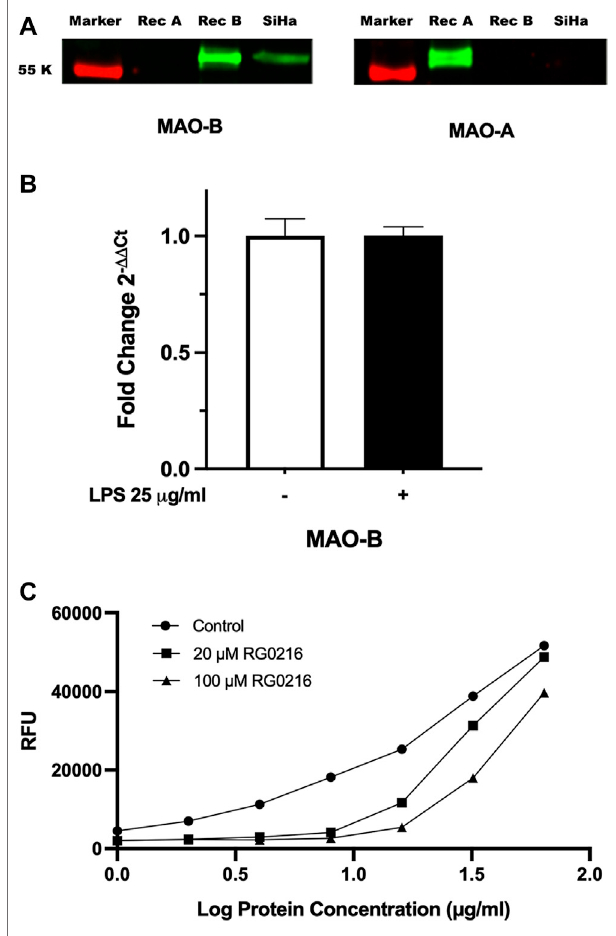
FIGURE 1 | MAO-B protein is only expressed in SiHa cells. (A) MAO-A andMAO-BproteinexpressionwasexaminedincelllysatesusingSDS-PAGE and Western blotting. Recombinant MAO-A (Rec A) and MAO-B (Rec B) proteins included as positive control. Left blot stained with anti-MAO-B primary antibody and right blot stained with anti-MAO-A primary antibody. Only MAO-B protein was expressed. (B) LPS stimulation had no effect on MAO-B relative gene expression. Data presented as mean ± SD ( n (cid:2) 3). (C) RG0216inhibitsMAO-BfunctionalactivityinSiHacelllysates.MAO-Benzyme activity represented as Relative Fluoresence Units (RFU). Data presented as mean ( n (cid:2) 2).